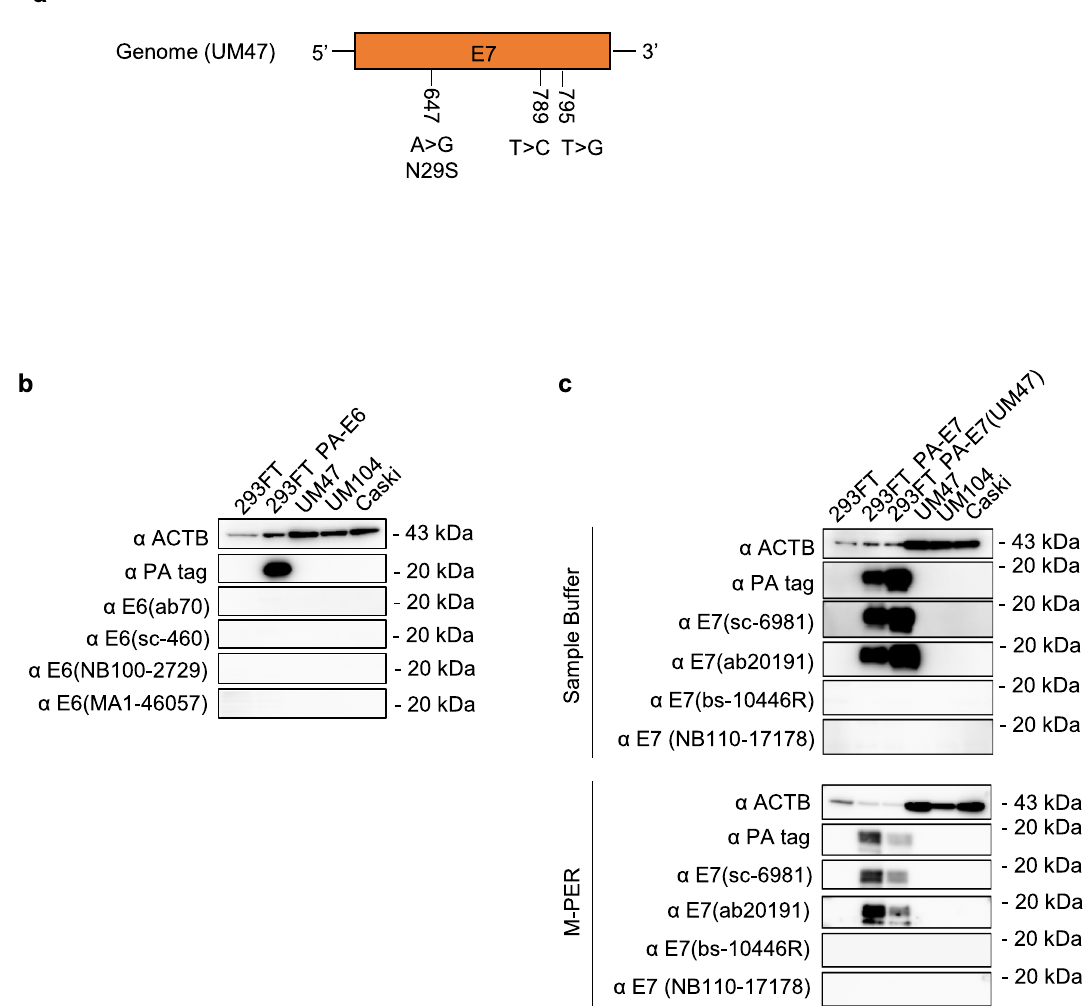
Figure 1. Detection of E6 and E7 proteins using specific antibodies against E6 and E7 in the head and neck carcinoma and cervical carcinoma cell lines. ( a ) The positions of the three mutations in the E7 sequence in UM47. ( b , c ) Western blotting of E6 ( b ) and E7 ( c ) proteins in 293FT cells (wild-type), 293FT cells transfected with pCAGIP-PA-E6/-PA-E7, and wild-type HPV16 (+) cell lines (UM47, UM104, and Caski). ( c ) The E7 proteins were extracted using the sample buffer or with